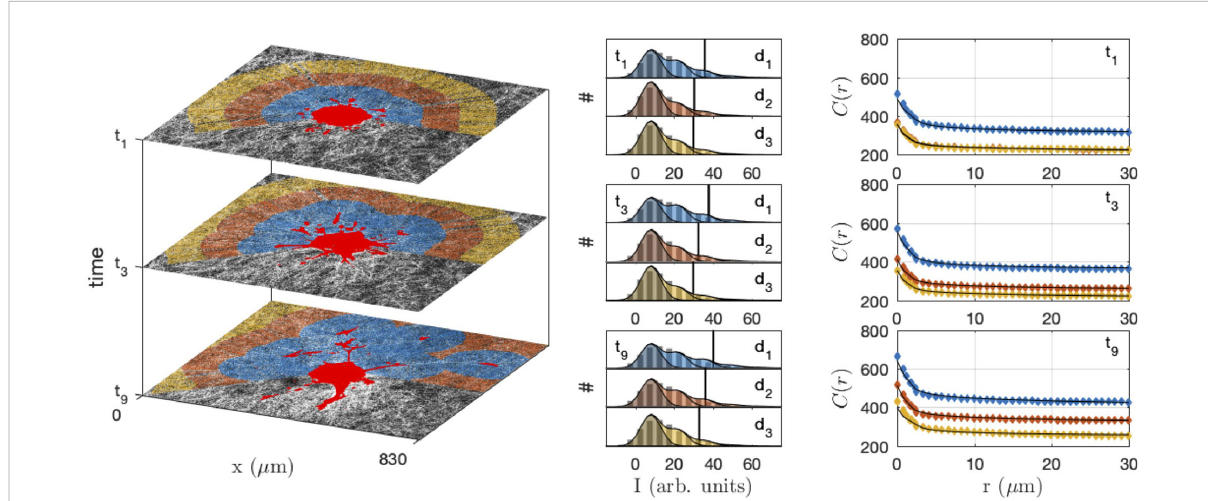
FIGURE 9 Collagen structure analysis in the neighbourhood of the CAF spheroid, at different times ( t 1 = 30 min, t 3 = 210 min, t 9 = 750 min) and distances from the cells ( d 1 < 100 µ m, 100 µm< d 2 < 200 µm and 200 µm< d 3 < 300 µm). In the original images (left) the gel is shown in grey and the cells in bright red, and the same colour code is used for the distances in the grey-tone distributions (middle) and correlation functions (right). The middle panel displays the histogram of grey-levels (pixel counts # against their intensity I), with the bars being the experimental distributions, etc. The shaded areas are the grey-tone model, with the background contribution (darker) and increasing number of fi bre overlaps. In the right panel the grey-tone correlation functions C ( r ) are shown, with the dots being the experimental values and the solid lines being the grey-tone